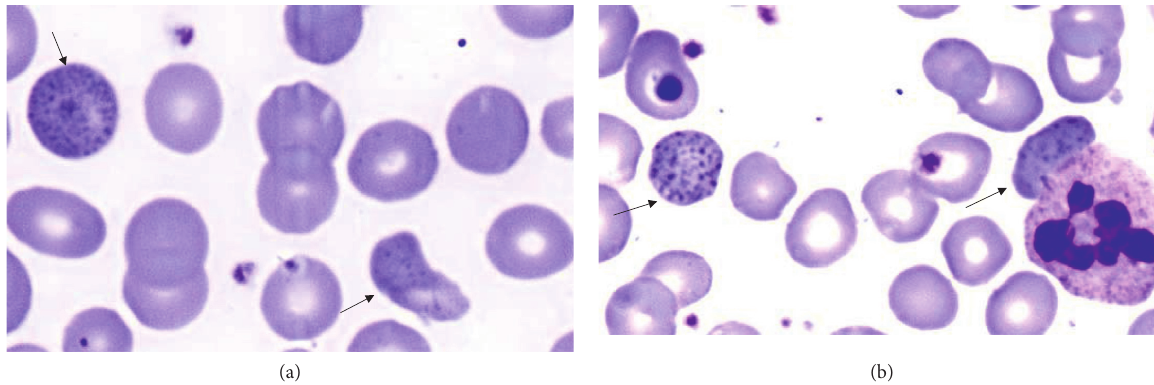
Figure 2: (a, b) Peripheral blood smear with basophilic stippling of red blood cells (arrows) (Wright–Giemsa, × 1000). Table 1: The initial and posttreatment results (after 4 weeks) of the laboratory tests.